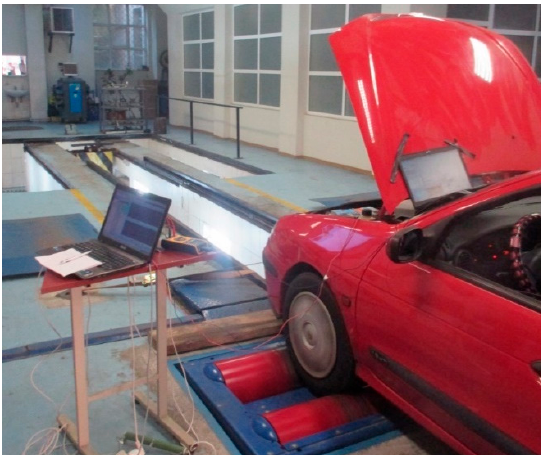
Figure 13. Experimental research for 1.9 dm 3 engine with hybrid turbocharger on Maha Dynamometer Stand.